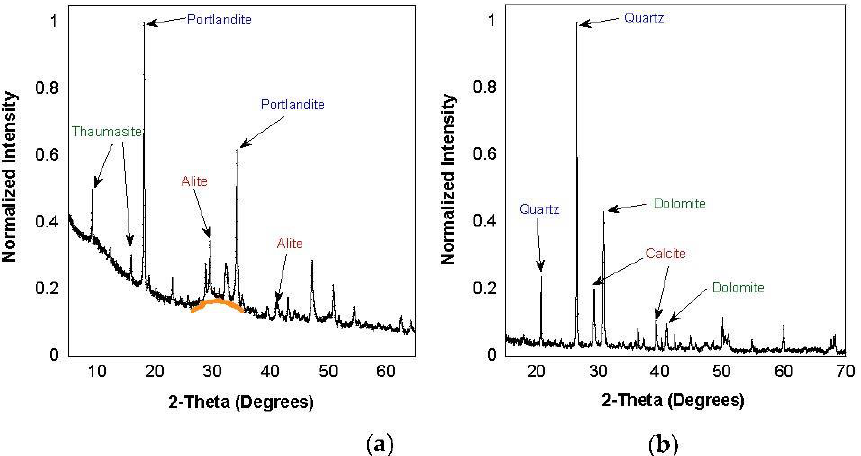
Figure 3. XRD pattern of ( a ) cement and ( b ) concrete dust. Table 2. Quantification of crystalline phases in concrete dust from XRD.